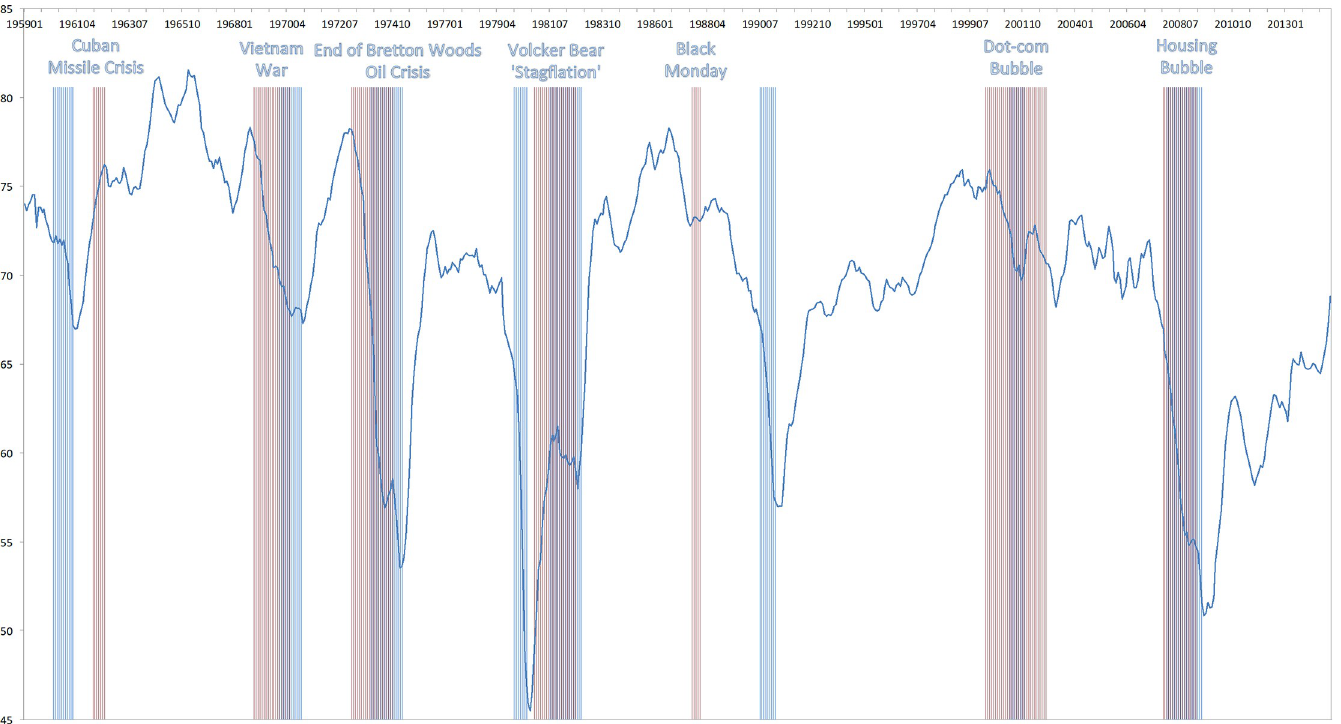
Fig 1. Euphoria Index, S&P 500 bear markets and NBER recession periods. The Figure depicts the level of the Euphoria Index for a time period 1959 until 2014. The highlighted areas present the NBER recession periods (in blue) and the S&P 500 bear markets (in red). For each of the historic bear markets, I indicate the source of the overall pessimism on Wall Street in that